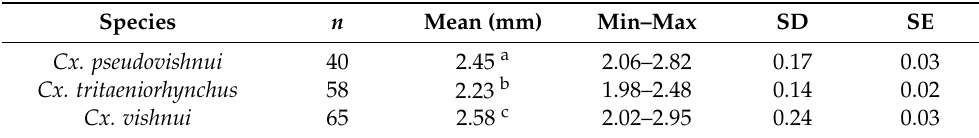
Table 1. Statistical differences in mean wing centroid size of Cx. pseudovishnui , Cx. tritaeniorhynchus , and Cx. vishnui